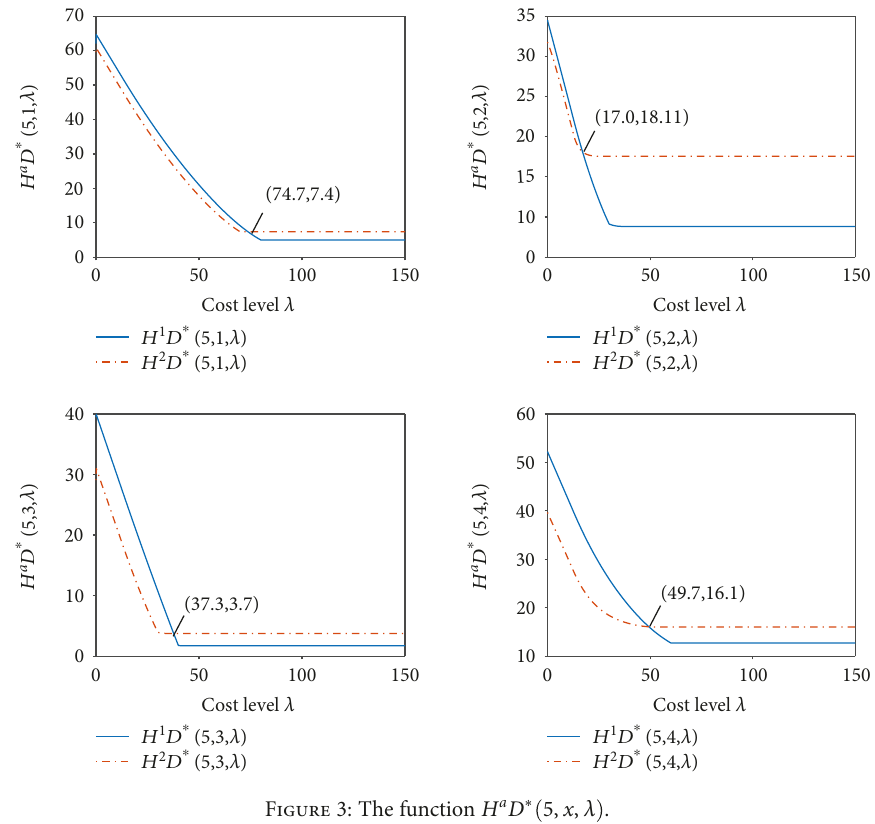
Figure 3: The function H a D ∗ 5, x , λ .